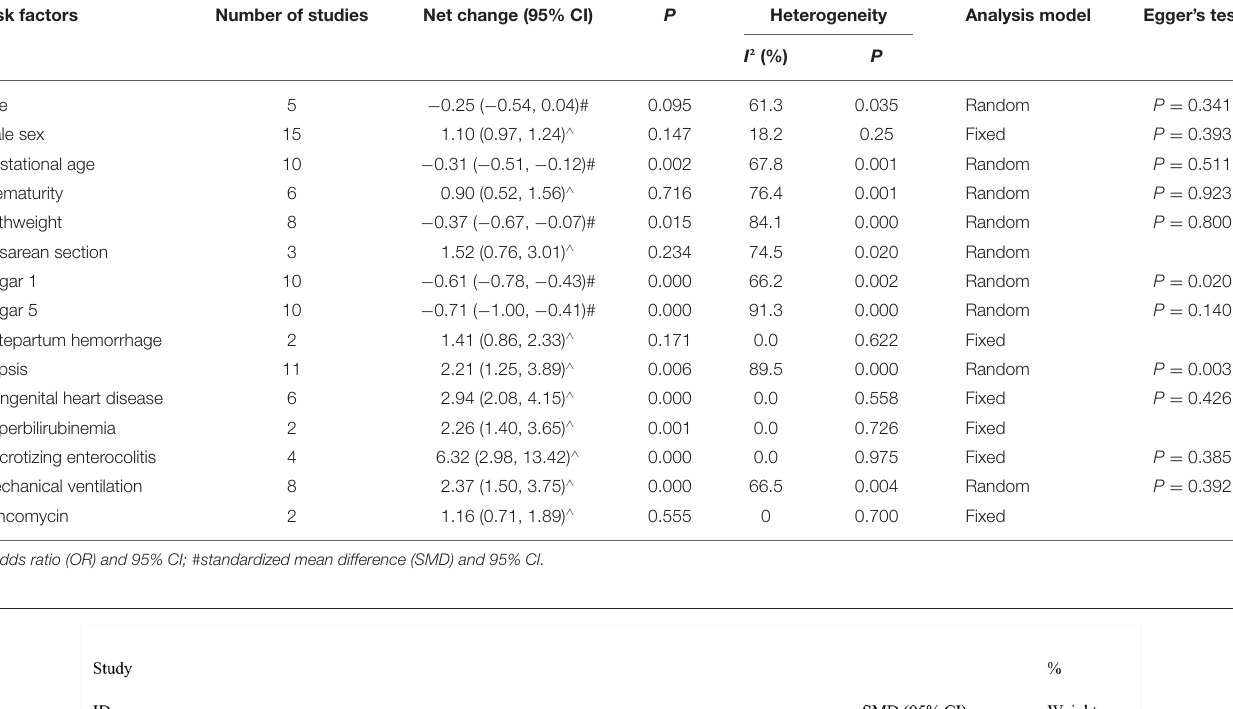
had lower values of gestational age [SMD = − 0.31, 95%CI = ( − 0.51, − 0.12), P = 0.002] ( Figure 2 ), birthweight [SMD